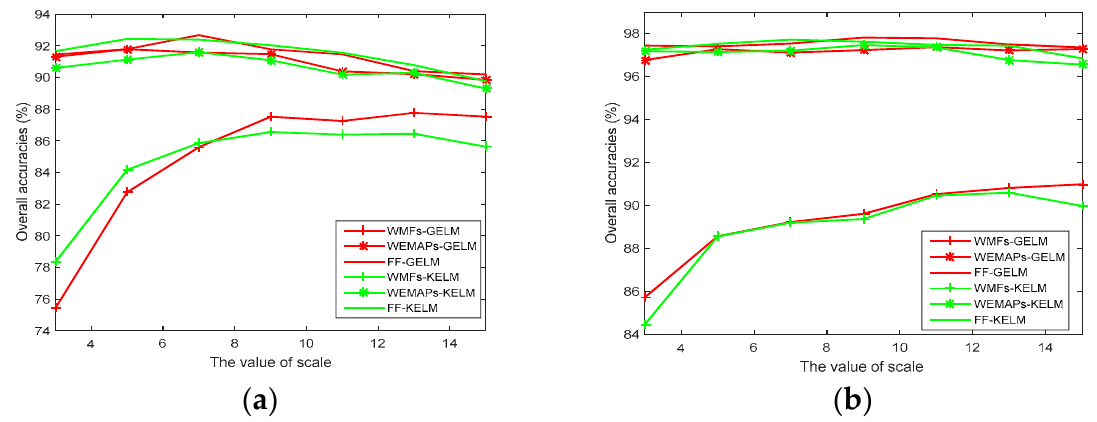
Figure 2. The impacts of the window scales of the WMFs, the proposed WEMAPs, the FF on the GELM and the KELM. ( a ) The classification results on Indian Pines dataset. ( b ) The classification results on the Pavia University dataset.